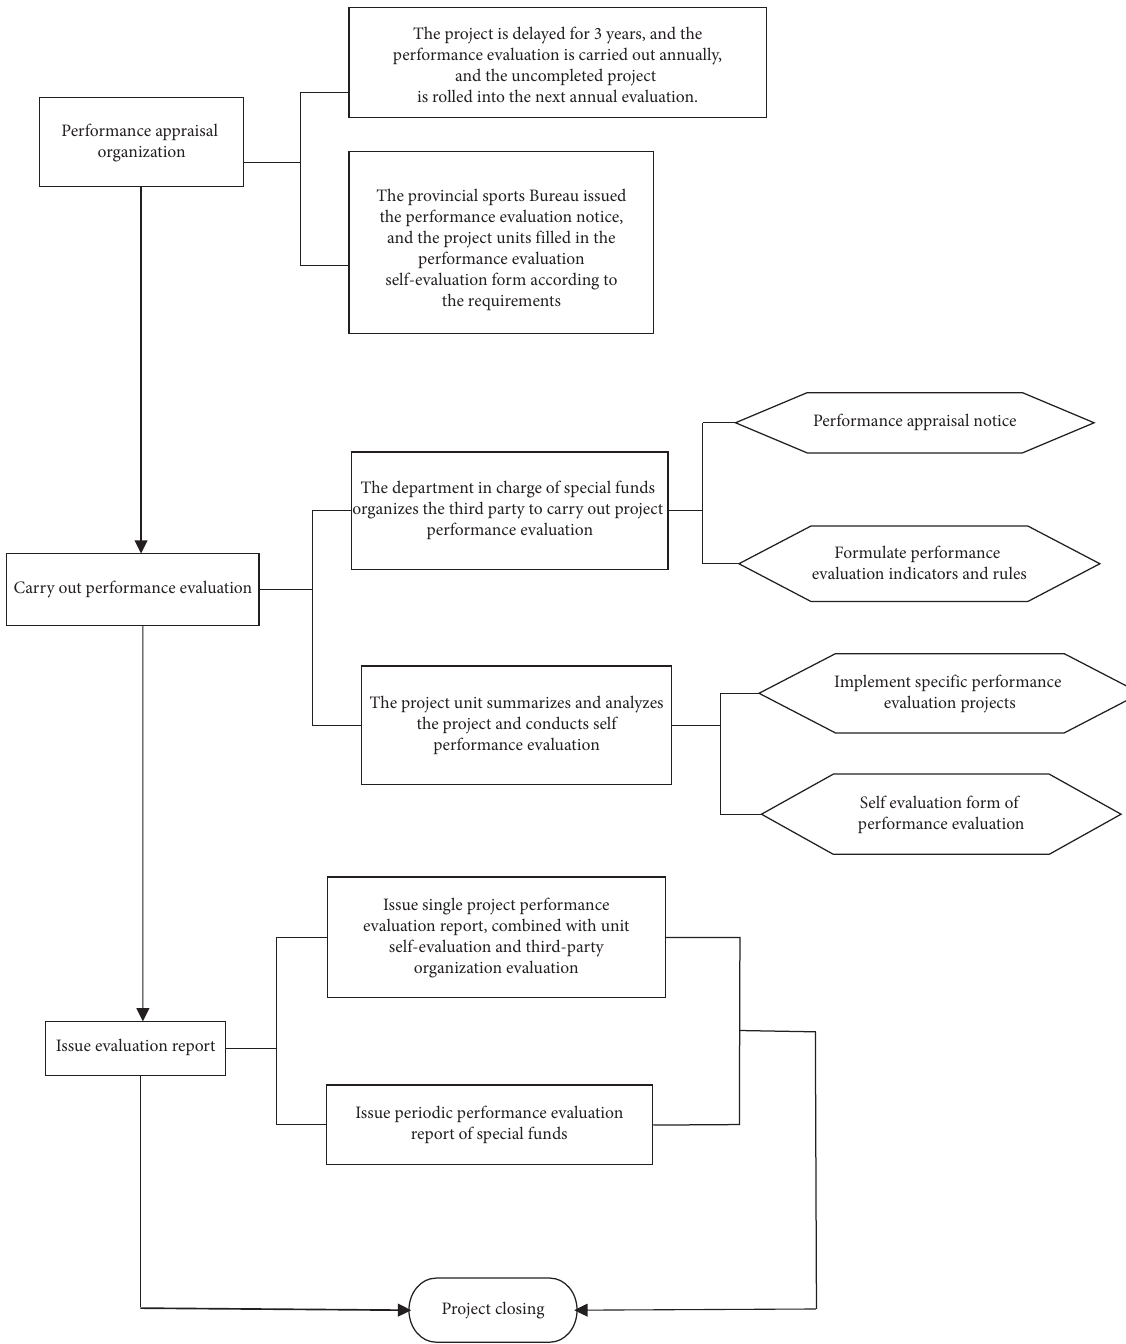
Figure 3: Implementation process of performance management of special funds for sports industry development in Jiangsu